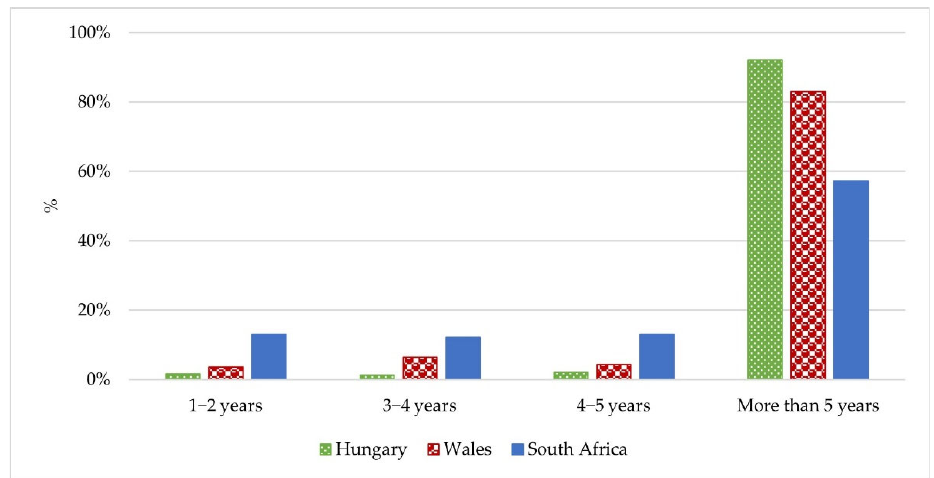
Figure 15. The number of years students have been using digital devices.